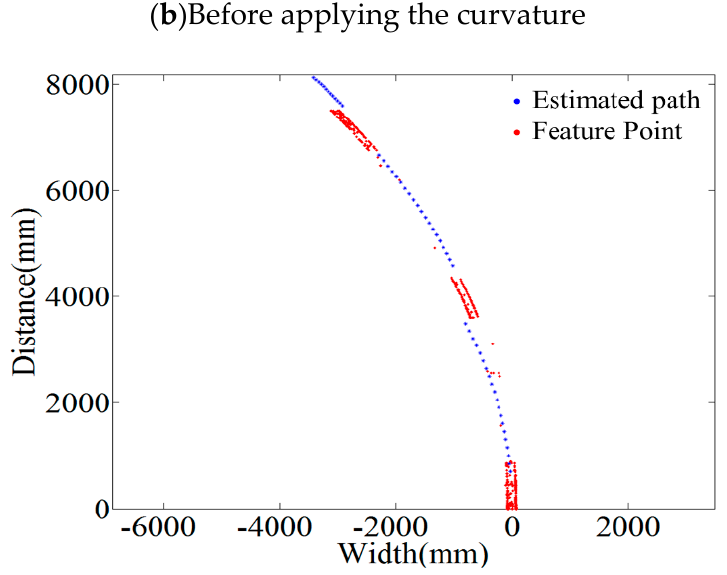
Figure 19. Lane prediction when some lanes are not recognizable.